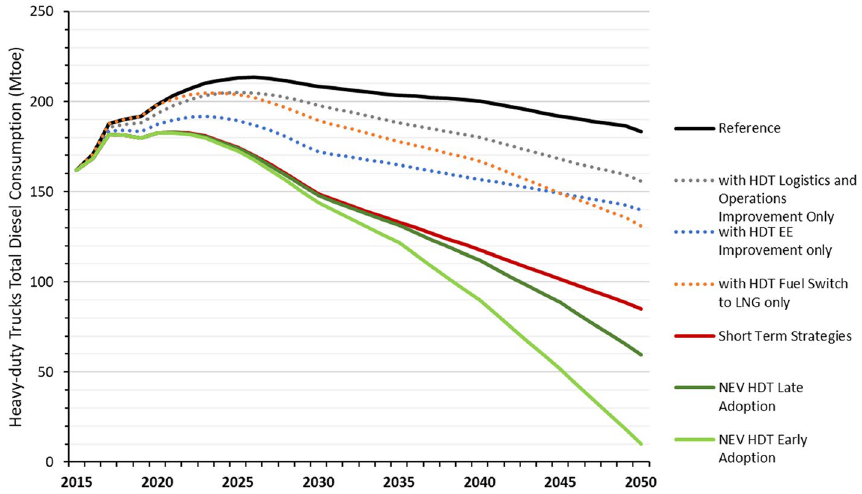
Figure 2. Different strategies’ impact on heavy-duty trucks’ diesel consumption. EE energy-efficiency, NEV new energy vehicle (battery electric, fuel cell).